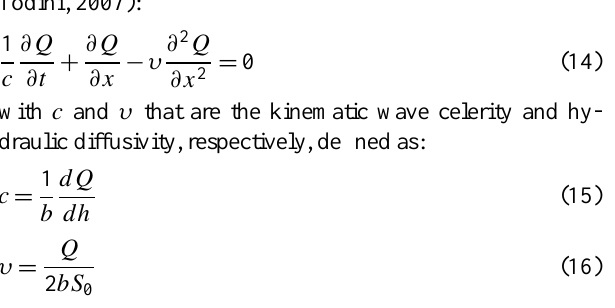
Fig. 3. The Moscardo Torrent basin (3) and its alluvial fan (4). (1) Debris flow initiation area; (2) instrumented channel stretch where two ultrasonic sensors are placed 75m apart from each other.